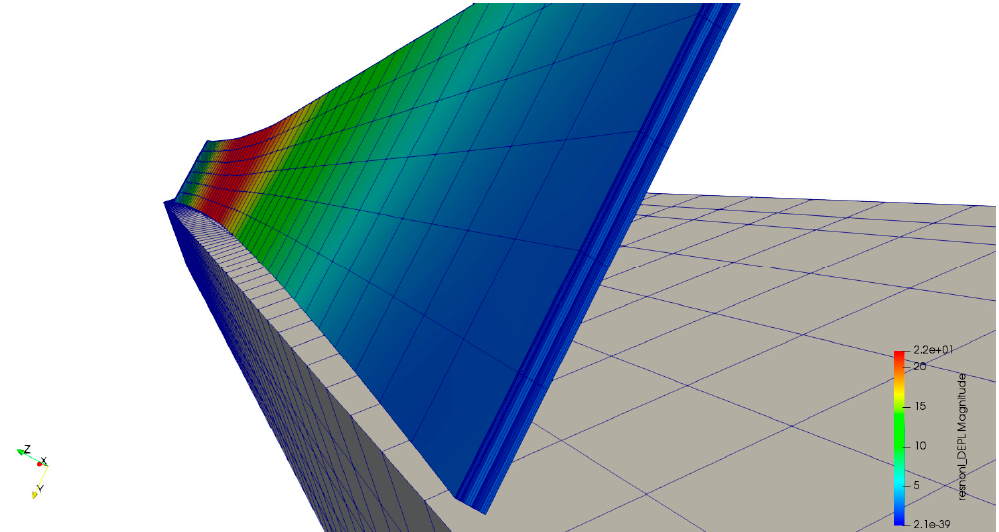
Figure 17. Ski in contact with the snow: Roll angle 45°, load 200 kg.